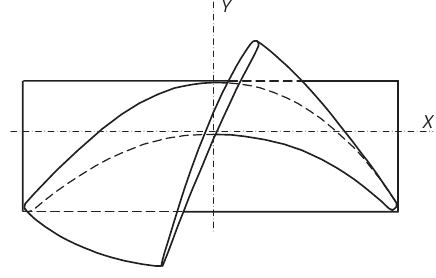
Fig. 2. View of pre-twisted blade from tip toward